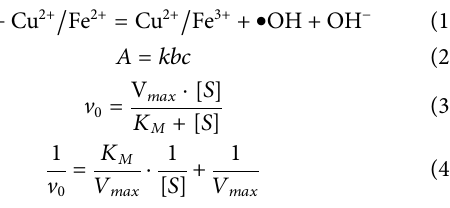
Frontiers in Materials |